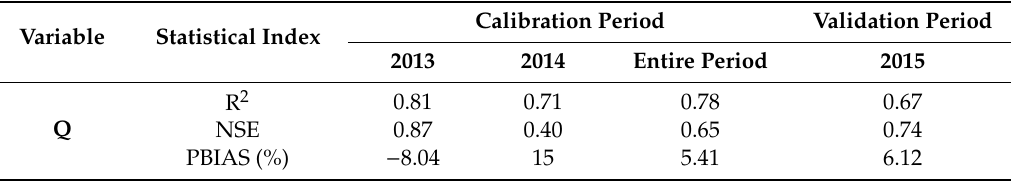
Table 1. Performance statistics for the calibrated APEX-Paddy model, including the coe ffi cient